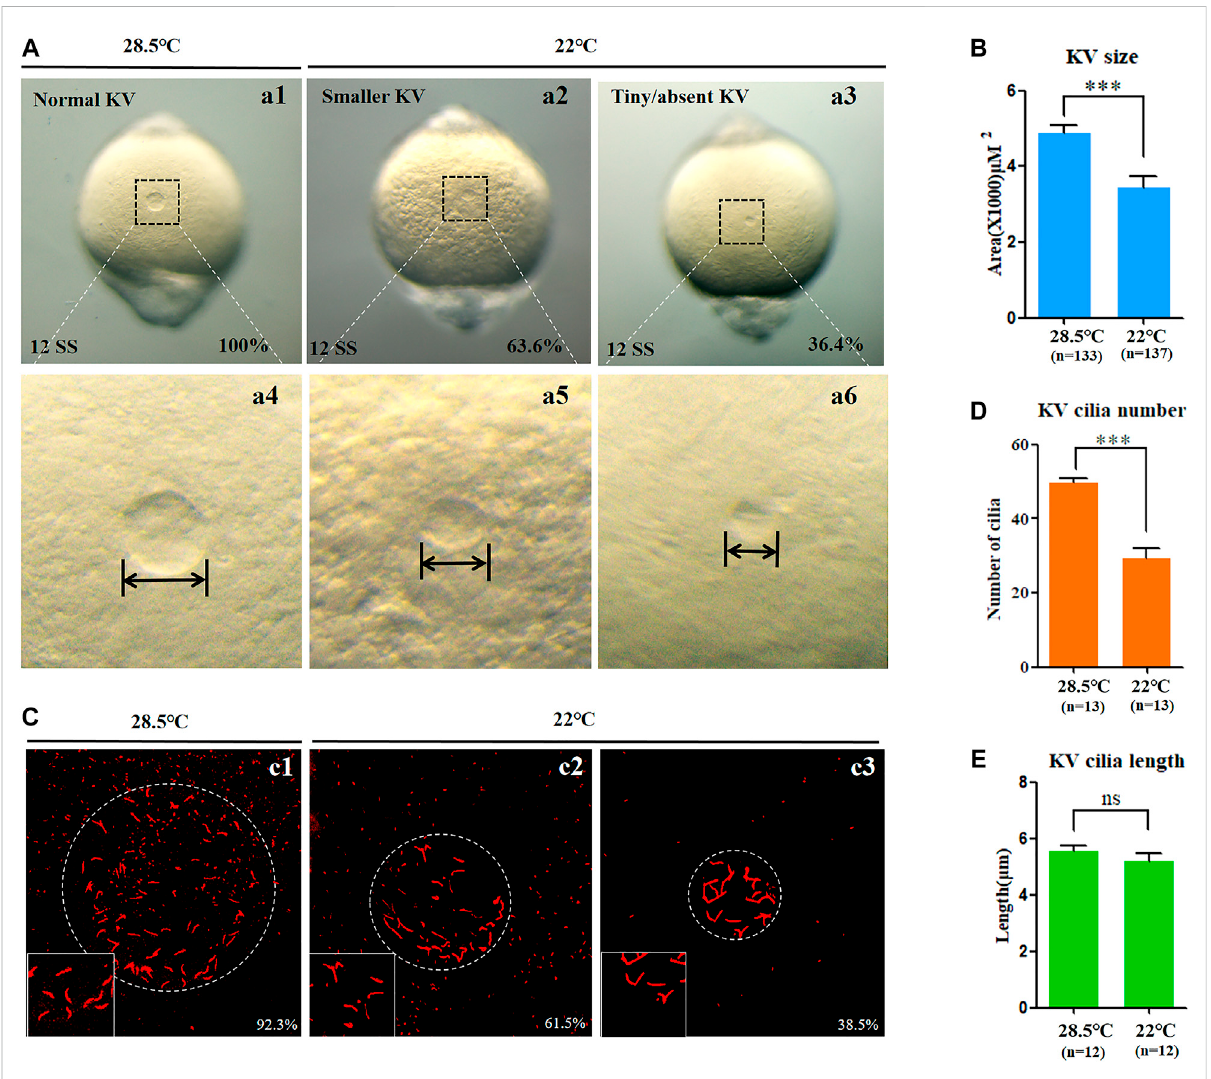
FIGURE 3 KVmorphogenesisandciliogenesisinembryostreatedwithmildcoldstress. (A,B) MorphologyofKV.a1,normalKVat28.5 ° C(100%, n =133);a2, smaller KV at 22 ° C (63.6%, n = 137, p < 0.001); a3, tiny/absent KV at 22 ° C (36.4%, n = 137, p < 0.002). (C) Number and length of cilia. C1, cilia at 28.5 ° C (92.3%, n =13);c2,ciliaat22 ° C(61.5%, n =13, p < 0.001);c3,ciliaat22 ° C(38.5%, n =13, p < 0.003). (D) StatisticalchartforcilianumberinKV. n =13, p < 0.001 (E) Statistical chart for cilia length in KV. n = 12. Ns, not signi fi cant; “ *** “ p <